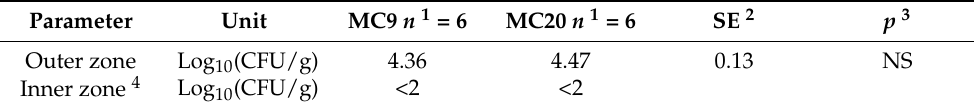
Table 6. Mesophilic lactic bacteria content in the outer and inner zones of cheese wheels produced by milk kept at the farm at 9 ◦ C (MC9) or 20 ◦ C (MC20) (least-square-mean values). Parameter